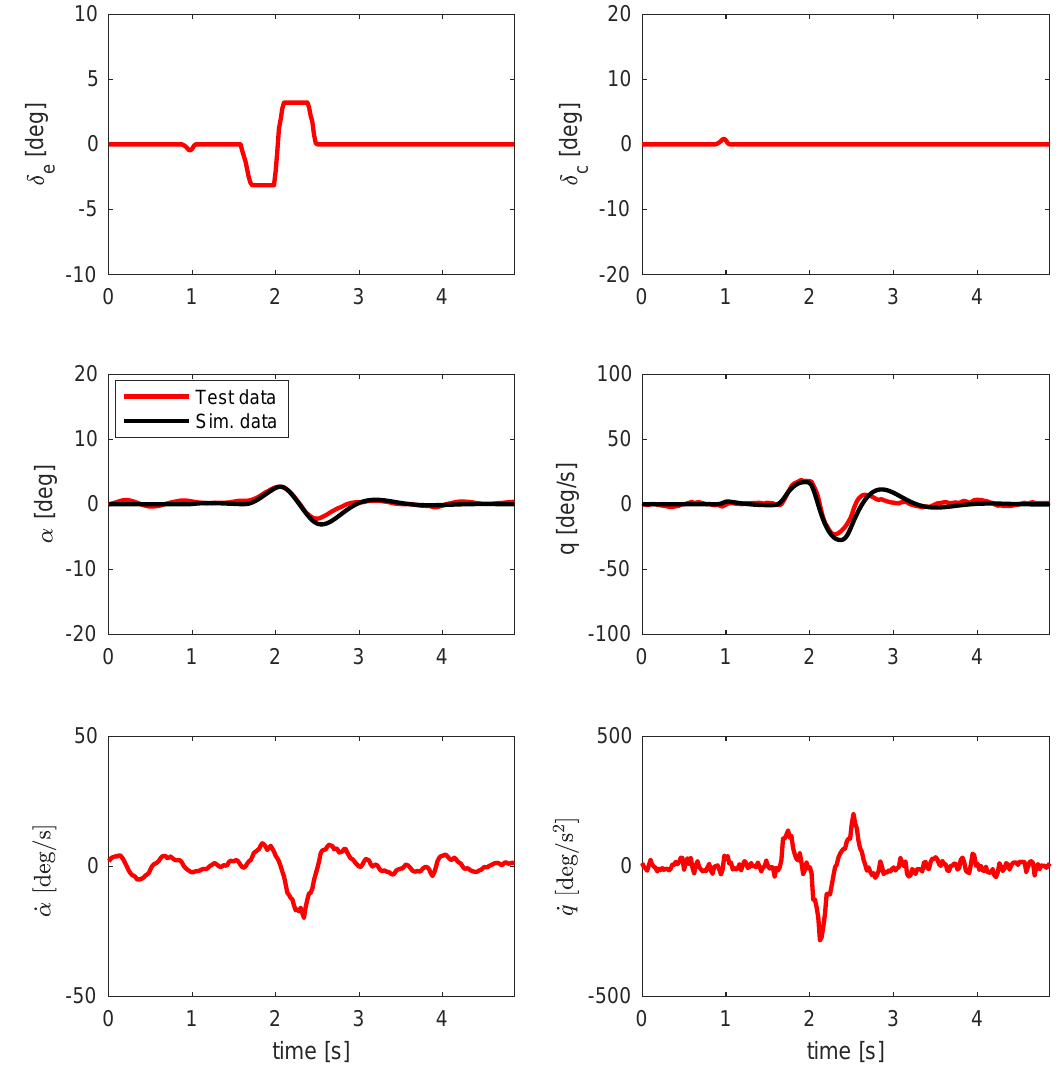
Figure 4. Estimation data from earlier flight tests. Test data are shown in red, while simulated model data are shown in black for the states angle-of-attack and pitch